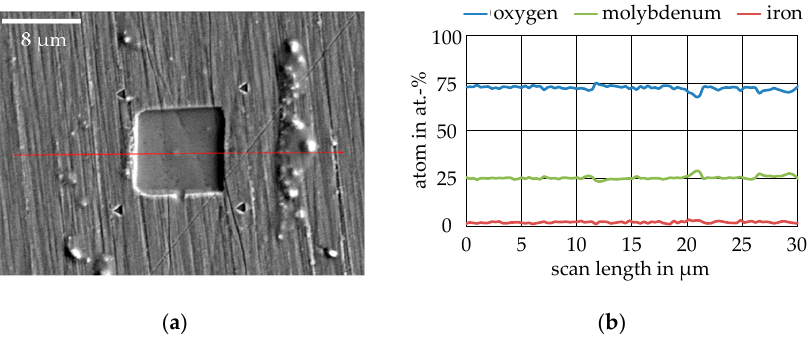
Figure 15. SEM examination of the wear field: ( a ) BSE image of a wear field with 200 µ N/35 P on MoO 3 and course of the line scan; ( b ) Result of the line scan from ( a